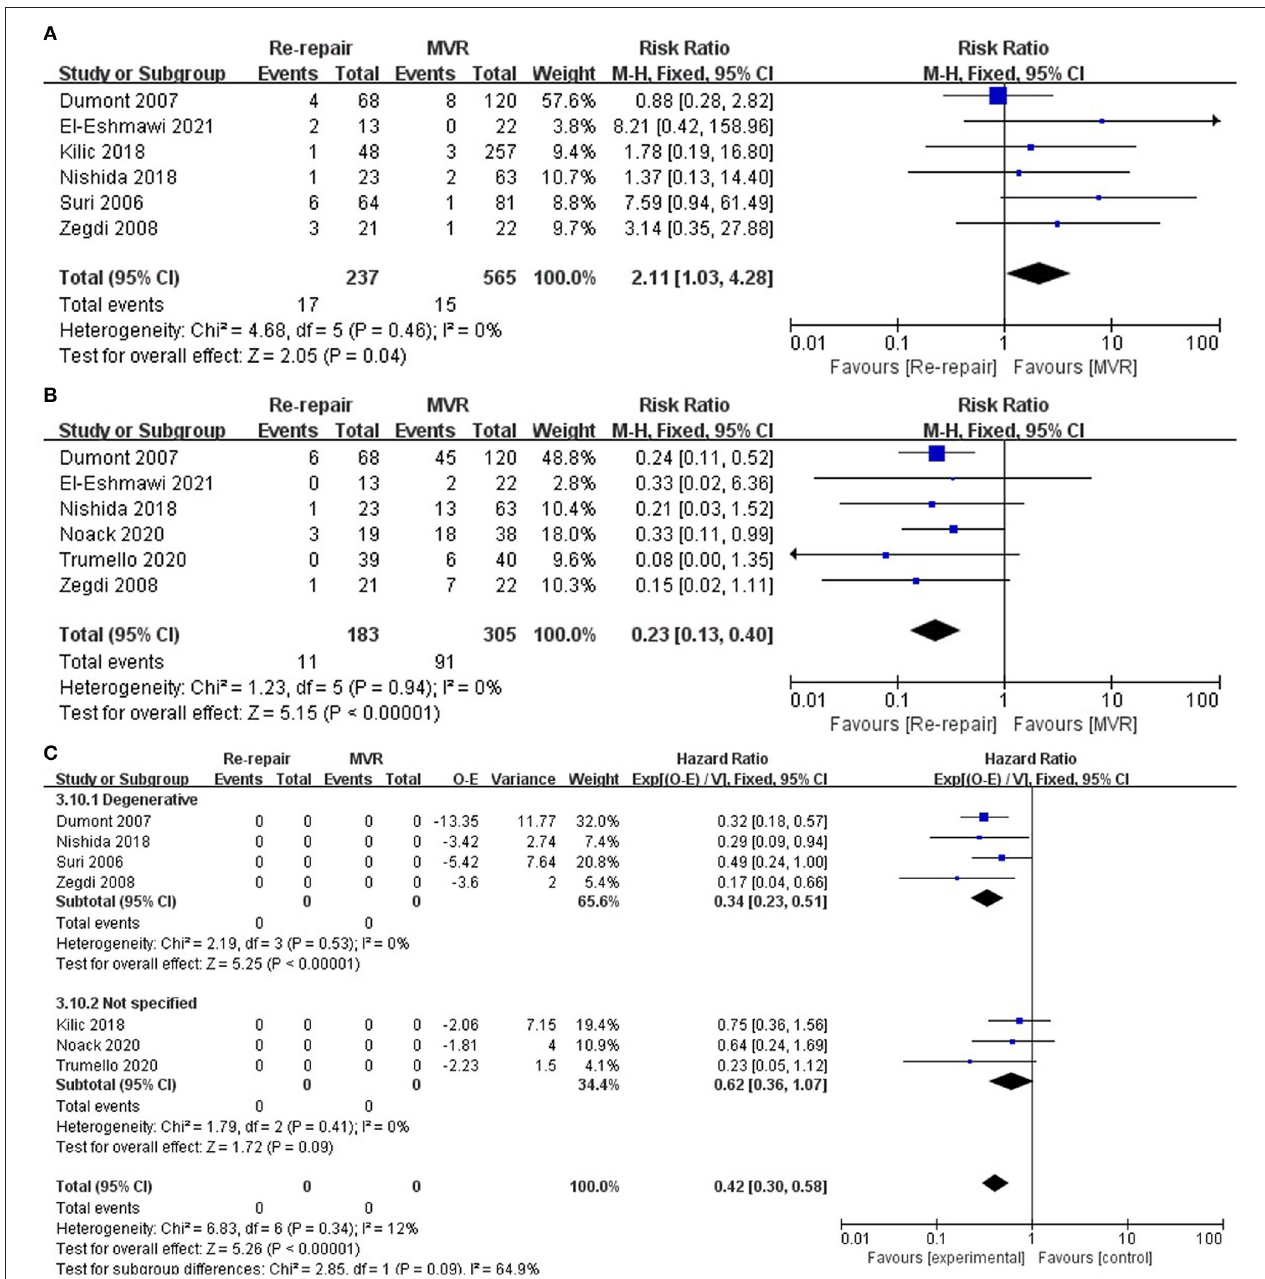
FIGURE 4 | Long-term outcomes. (A) Reoperation; (B) follow-up death, risk ratio pooled; (C) follow-up mortality, hazard ratio pooled. O-E, Observed minus expected events; IV, inverse variance; CI, confidence interval; M-H, Mantel-Haenszel; MVR, mitral valve replacement.